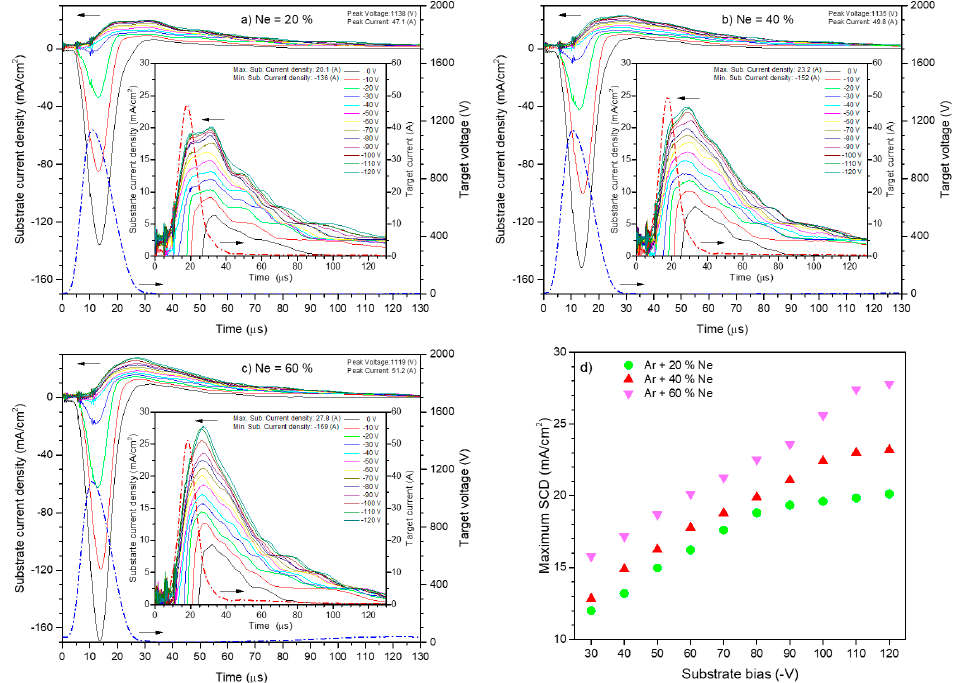
Figure 4. Time-resolved current densities at the substrate for substrate biases between 0 and − 120 V obtained with 20% Ne ( a ), 40% Ne ( b ), and 60% Ne ( c ) in the plasma. Maximum of the SCD curves as a function of the Ne content and substrate bias ( d ).